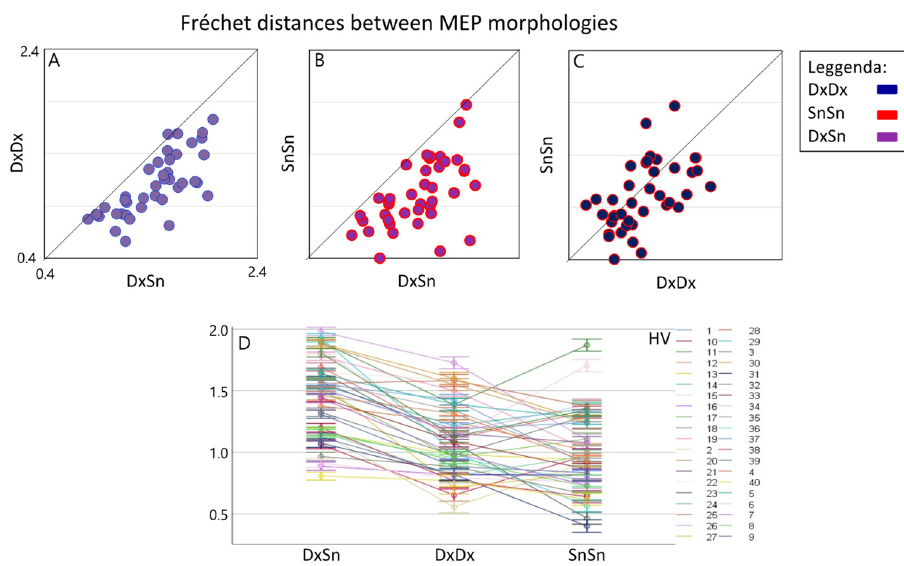
Figure 2. Inter-side and intra-side MEP morphology similarity. Boxplots of individual Fréchet distances between inter-lateral MEP morphologies (DxSn) (average of about 400 pairs in each HV, x - axis) versus intra-lateral distances (average of about 190 values). It is evident that the inter-lateral distance is higher than both the right intra-lateral distance ( A ) and the left intra-lateral distance ( B ) in all subjects. In the right intra-side comparison, a prevalence of greater distances emerges compared to the left ( C ). The overall values and standard deviation with subjects are shown in ( D ).